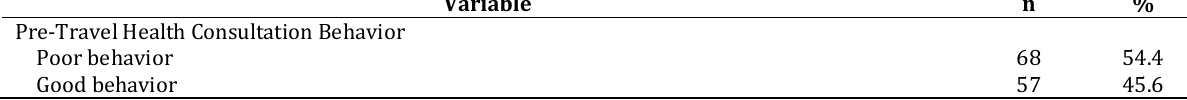
Table 2. PTHC Behavior among International Travelers in Badung, Bali in 2020 (n=125)